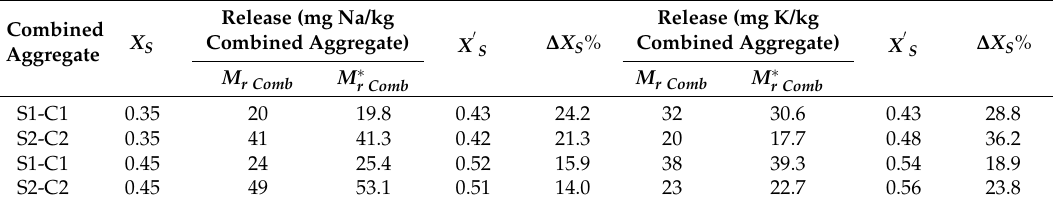
Table 7. Estimated ∆ X S % values for the S1-C1 and S2-C2 aggregate